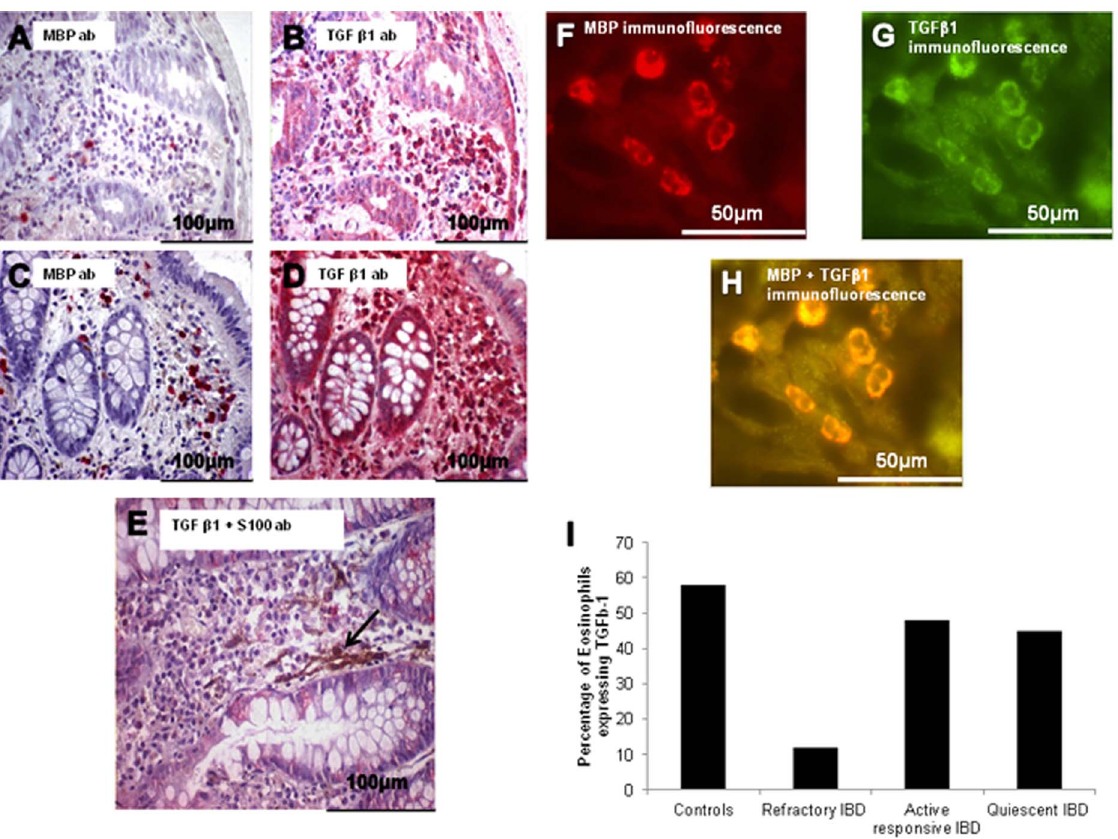
Figure 6. Eosinophilic expression of TGF b -1. Photomicrographs (A-D) are paired serial sections taken from patients with active (A, B) and quiescent (C, D) UC. (A) and (C) were stained with an anti-MBP antibody while (B) and (D) were stained with an anti-TGF b -1 antibody. An illustratation of TGF b -1 immunoreactive eosinophil localization to neural tissue is arrowed in (E). Photomicrographs (F-H) represent a section from a patient with quiescent UC which was double immunofluorescently stained with anti-MBP and anti-TGF b 1. In (F) MBP positively staining cells confirms that these cells are eosinophils. In (G) the same section demonstrates TGF b 1 expression. (H) is a merged image of (F) and (G) confirming that these are TGF b 1 expressing eosinophils. (I) represents the results of the quantitative analysis of eosinophilic TGF b 1 expression. Eosinophilic TGF b 1expression is markedly reduced in patients with refractory IBD (12%) compared to controls (58%) and patients with therapeutically responsive IBD ( . 40%).